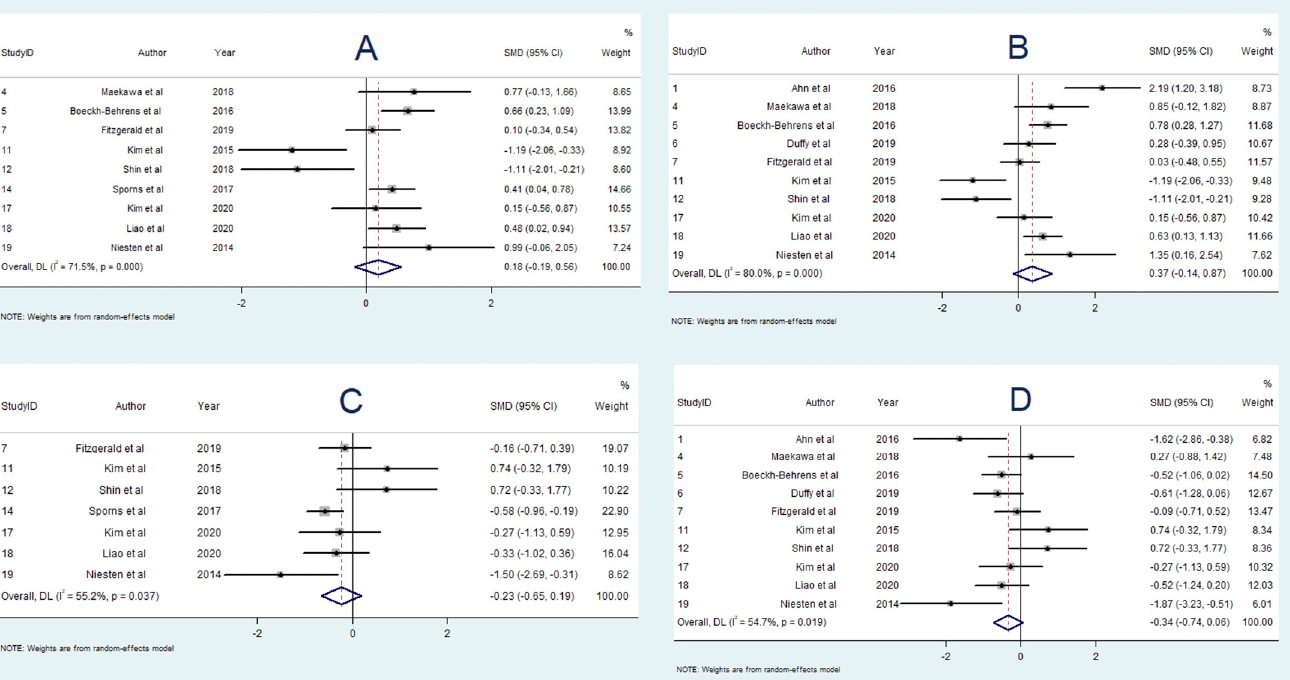
Figure 2. Forest Plots of Meta-analyses on RBC Content and Aetiology. ( A ): Non-cardioembolic vs. Cardioembolic Stroke. ( B ): LAA vs. Cardioembolic Stroke. ( C ): Cryptogenic vs. Non-cardioembolic stroke. ( D ): Cryptogenic vs. LAA stroke. Abbreviations: DL: DerSimonian and Laird method, SMD: Standarized Mean Difference, CI: Confidence Interval, RBC: Red Blood Cell, LAA: Large Artery Atherosclerosis.